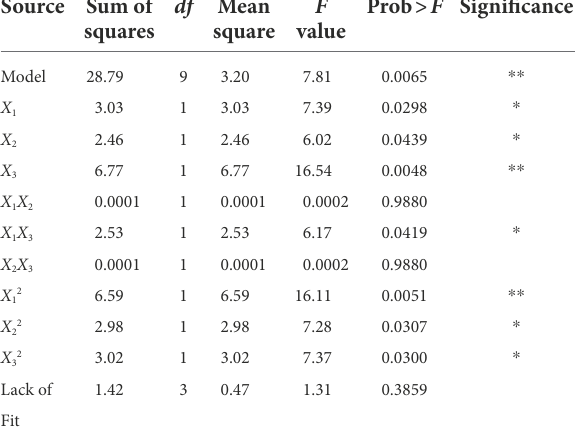
TABLE 2 Variance analysis of the effect of ethanol concentration, time and liquid/solid ratio on the anti- V. parahaemolyticus activity of the